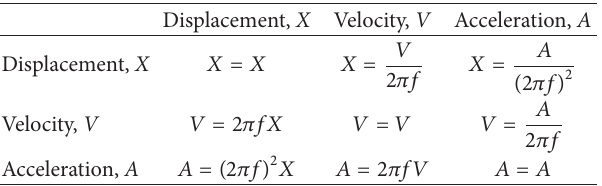
Figure 11: Vibrator table.